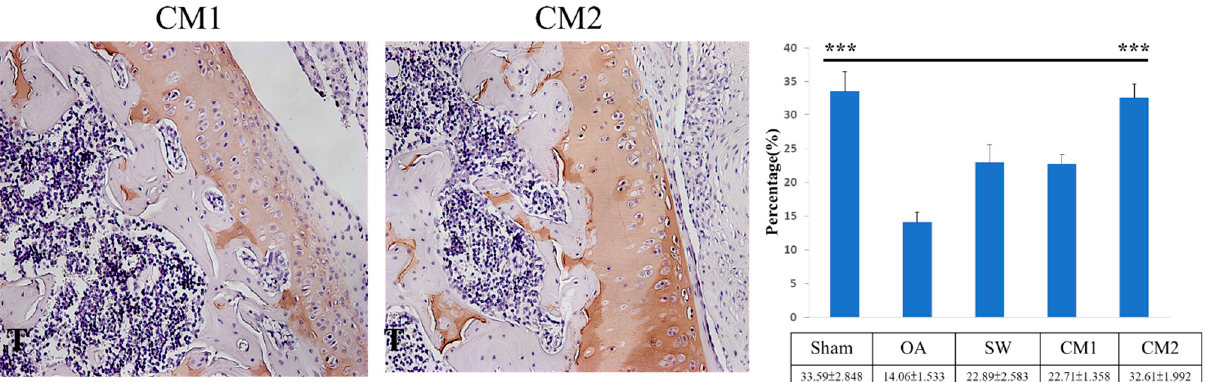
Figure 5. Immunohistochemical analysis for ( A ) SOX9 and ( B ) type II collagen (×400 magnification), and the percentage of SOX9 and type II collagen expression in the articular cartilage of the tibia for each group. * p < 0.05, ** p < 0.01 and *** p < 0.001 as compared with the osteoarthritis (OA) group. Eight rats were used for each group. Shockwave is indicated as SW. Osteoarthritis is indicated as OA. The 100 and 200 µ L adipose-derived mesenchymal stem cells-conditioned medium groups are indicated as CM1 and CM2, respectively.